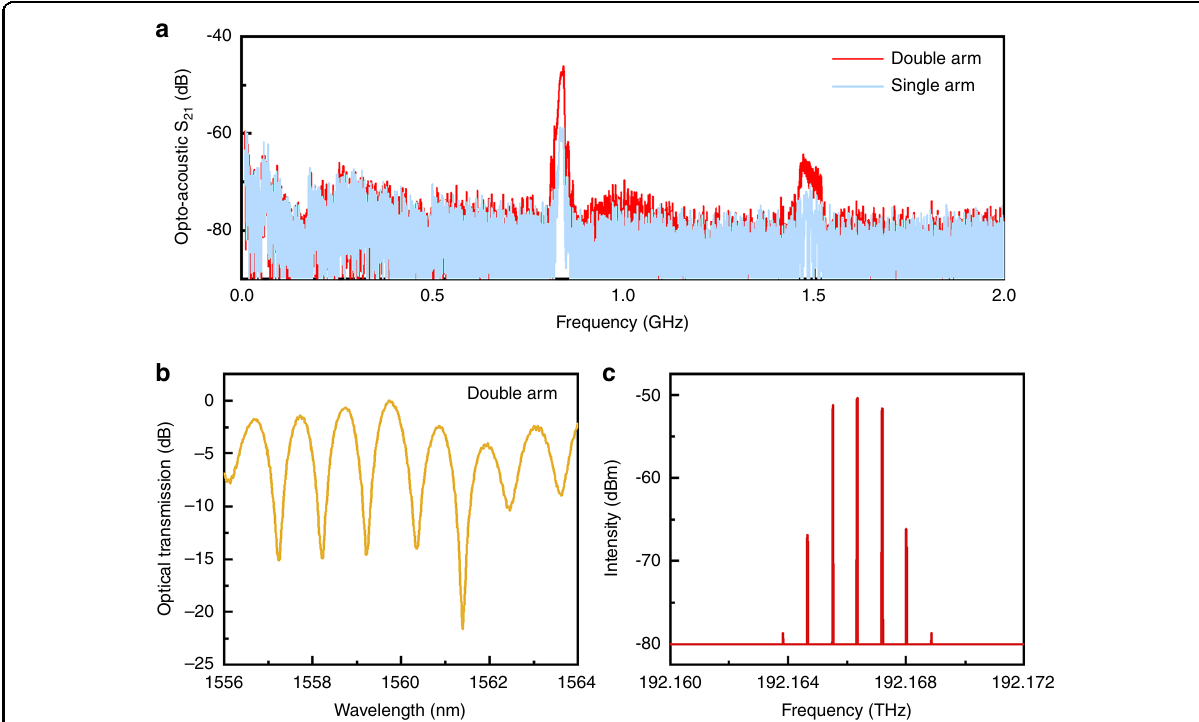
Fig. 4 AO modulation. a S 21 spectra of the TFLN-ChG hybrid MZI-based AO modulators with single-arm and double-arm modulation con fi gurations. b Normalized optical transmission spectrum of the AO modulator with the double arm con fi guration. c Measured optical sidebands in the push-pull AO modulator at an RF power of 15